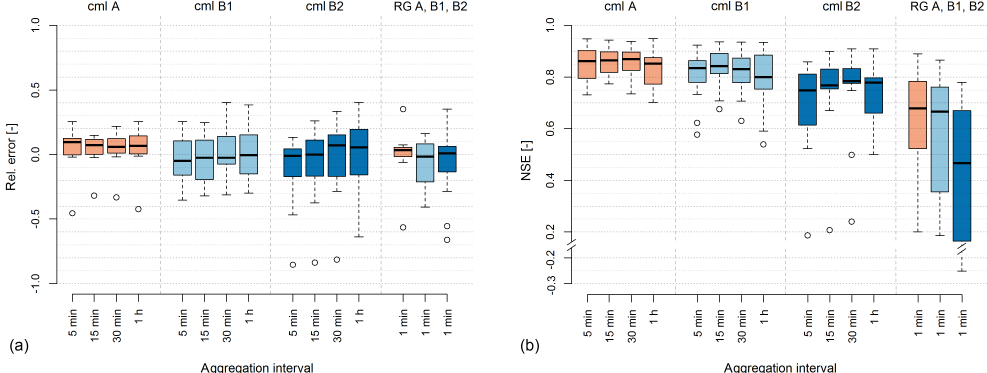
Figure 5. Relative error (left panel) and NSE (right panel) in QPEs from CMLs when adjusted using three different RG layouts (A, B1, B2) and four different aggregation intervals (5, 15, 30min, and 1h). Right three box plots in both figures correspond to RG observations of each layout when used alone without